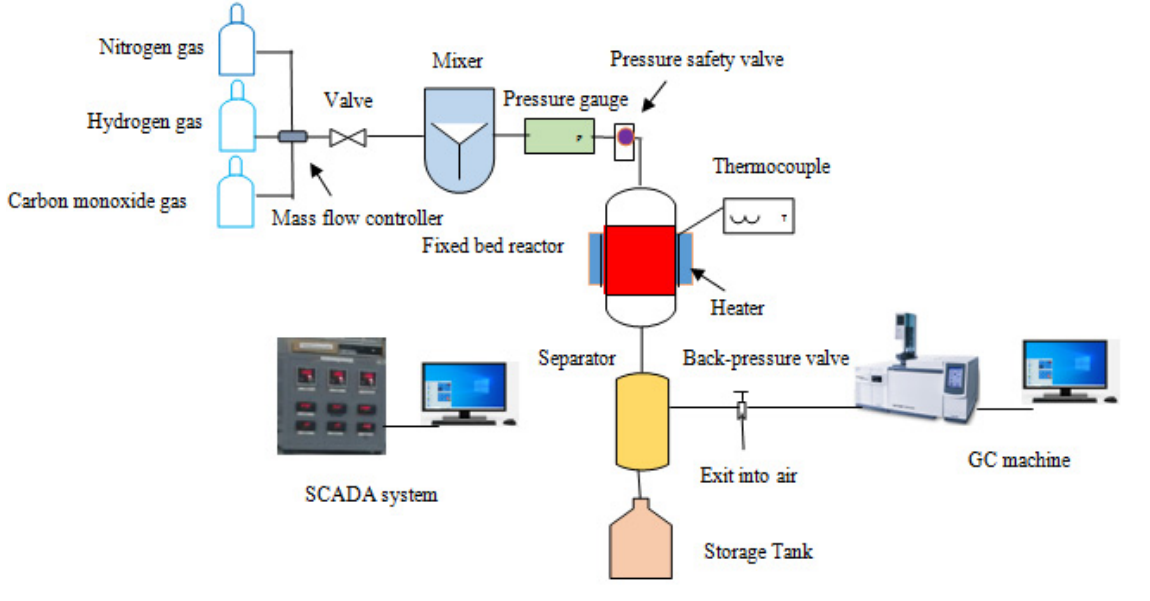
Figure 10. Schematic diagram of the FTS setup.